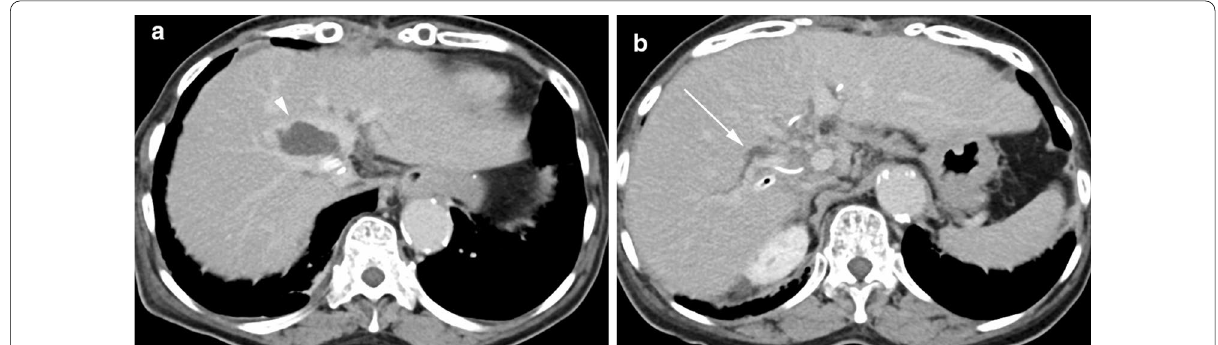
Fig. 1 a Contrast-enhanced computed tomography after hepatectomy shows biliary leakage (arrowhead). b Intrahepatic bile duct of right lobe is dilated around the intraoperatively repaired site (arrow)